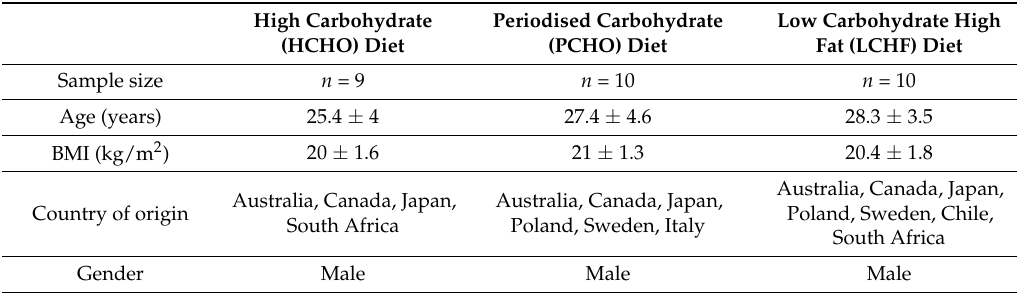
Table 1. Athlete cohort